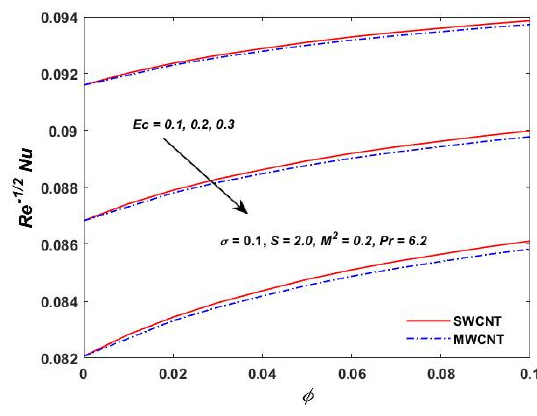
Figure 21. Eckert verses Re − 1/2 Nu